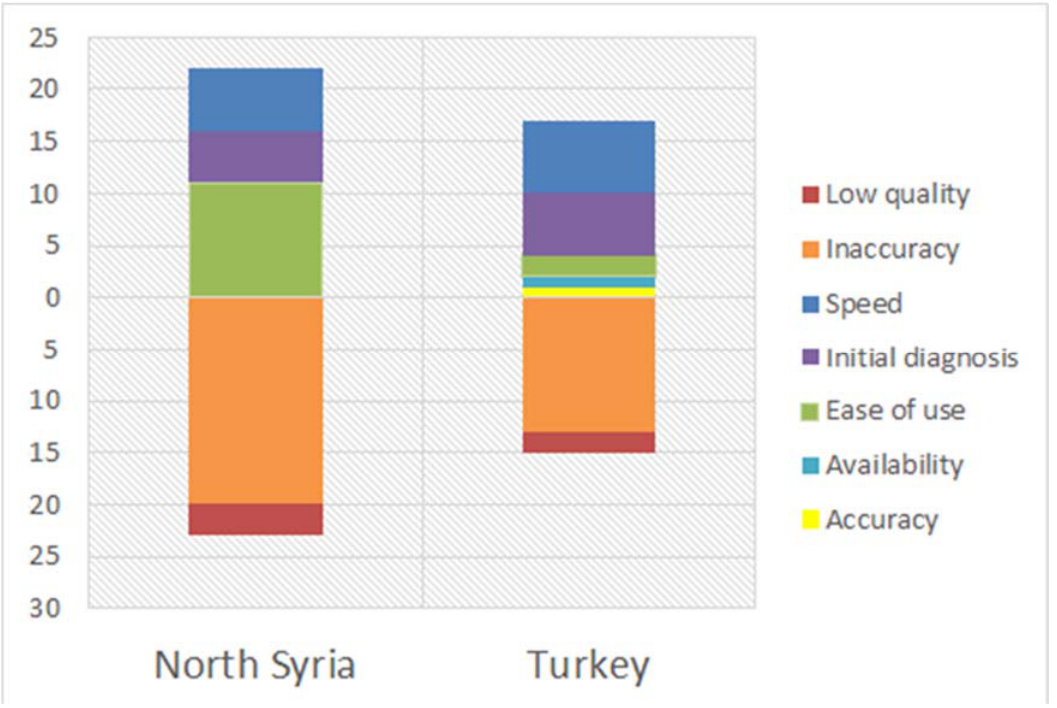
Figure 5. Advantages and disadvantages of PoC devices as seen by the surveyed clinicians based on their work location.